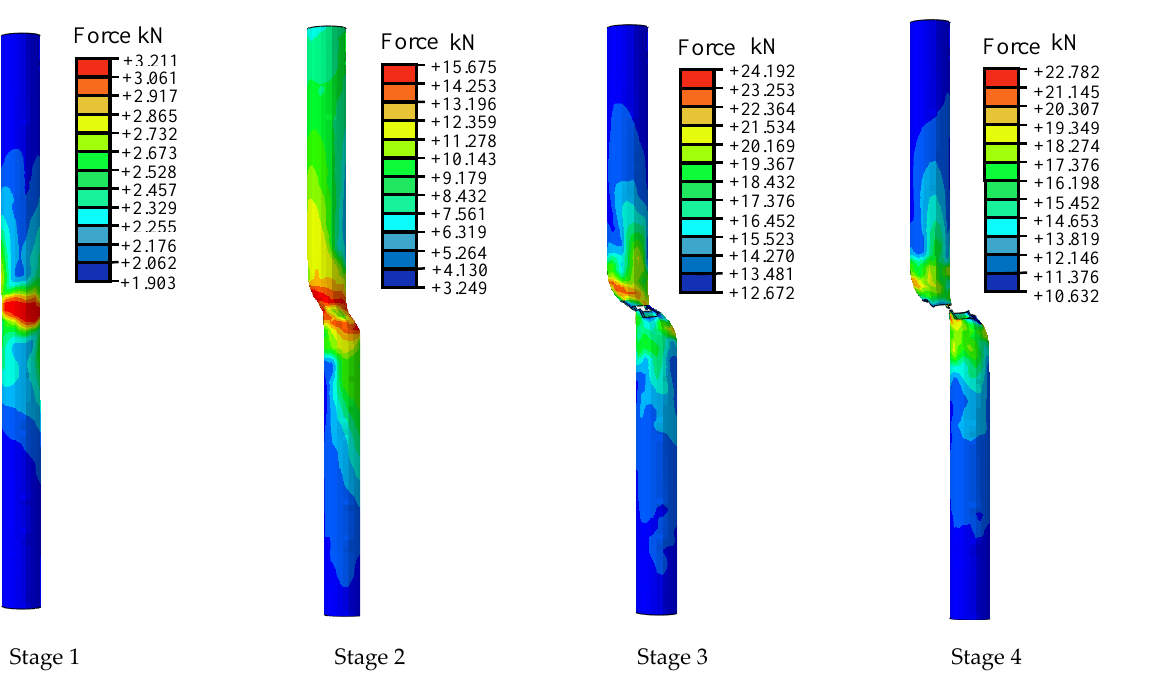
Figure 14. Stress distribution and evolution of the outer wall of the wellbore .